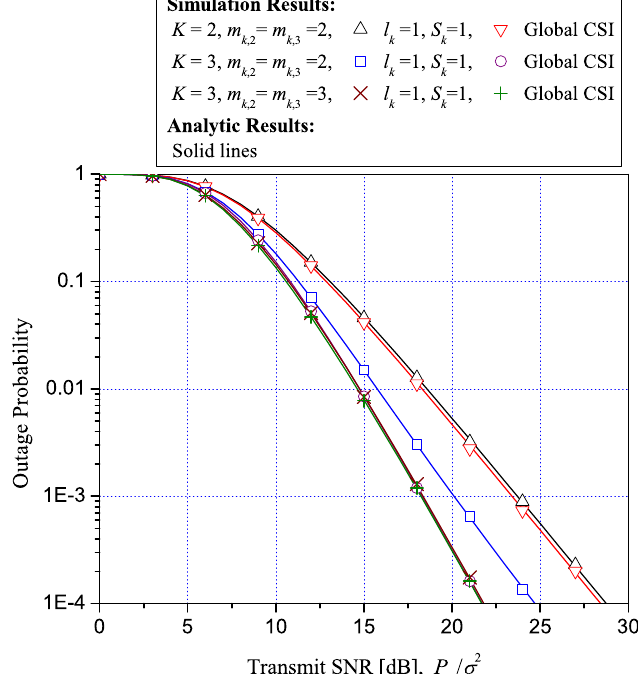
Figure 4. Outage probability for m k ,1 = 1, N k = 3, and l k = 1 for all k when K = 2,3 and R t = 1 bps/Hz.